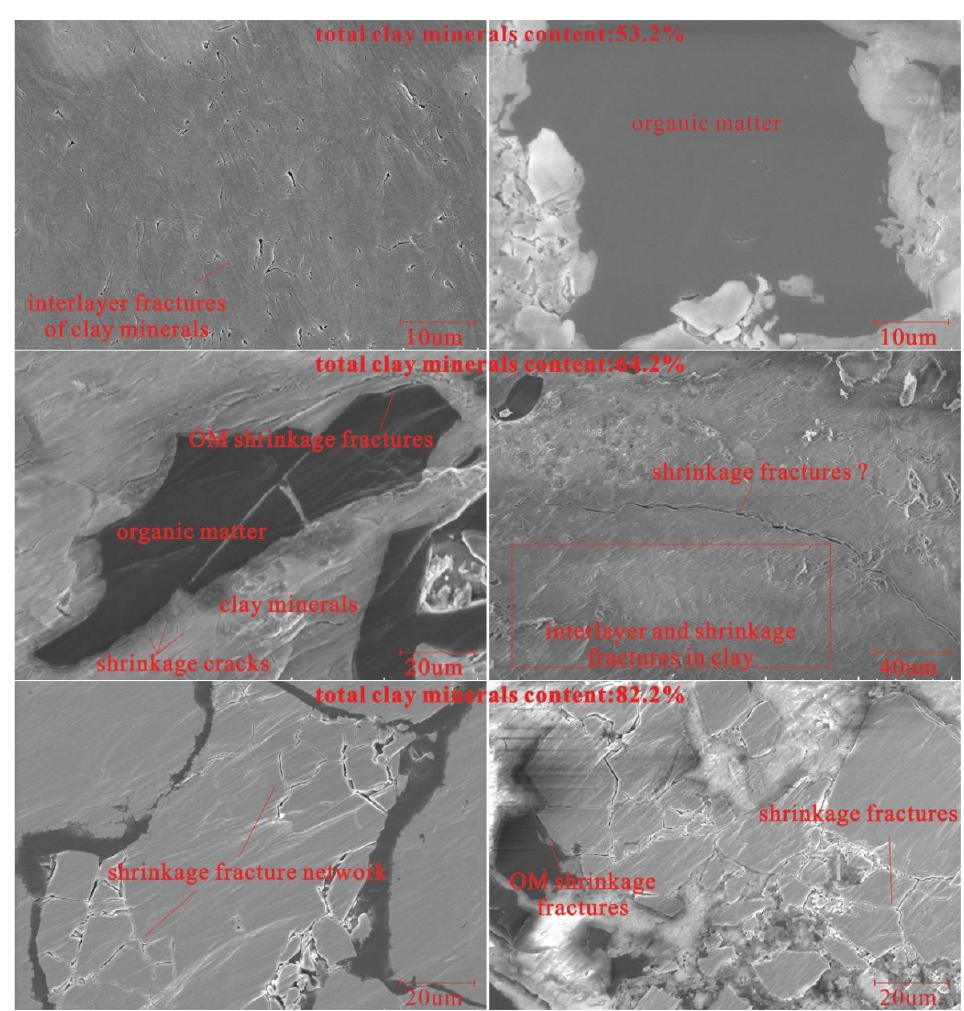
Figure 16. SEM micrographs of diagenetic shrinkage micro-fractures in lLongtan formation shale with different content of